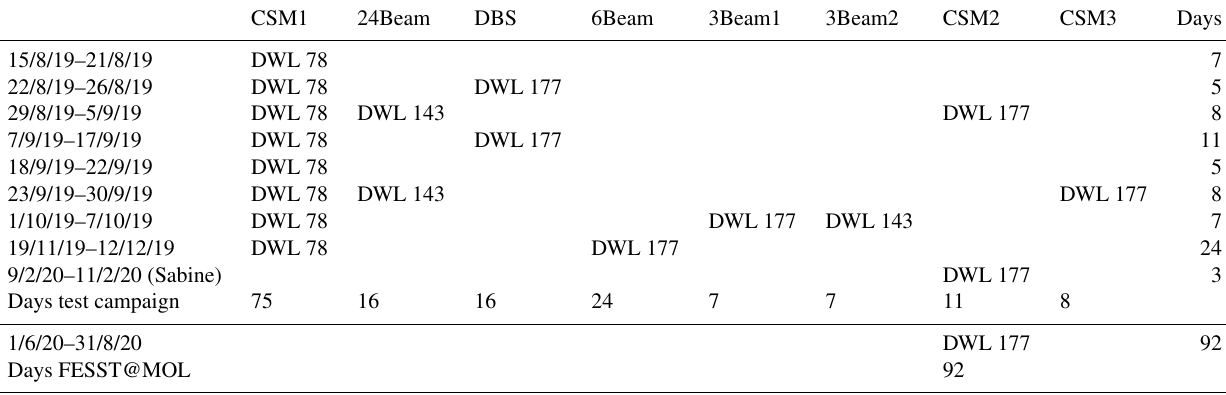
Table 2. Configuration time schedule (in day/month/year) for the DWLs used. CSM1 24Beam